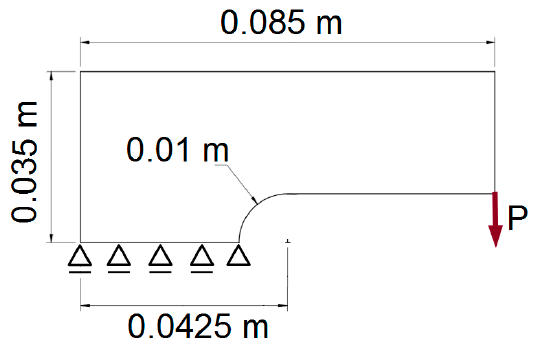
Figure 26. The final topology obtained using [35].